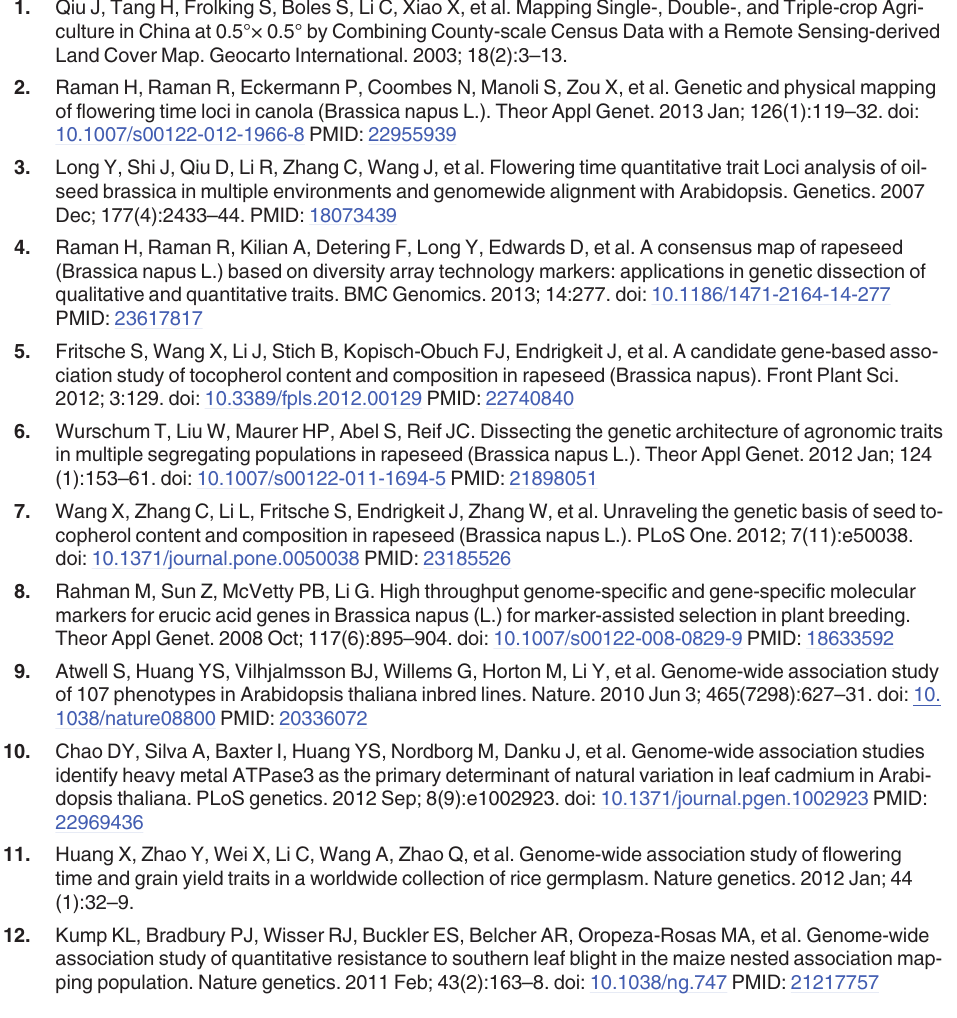
S5 Table. Top three functional groups of genes represented by SNPs common to all three geographic sites and specific to one or two regions respectively.